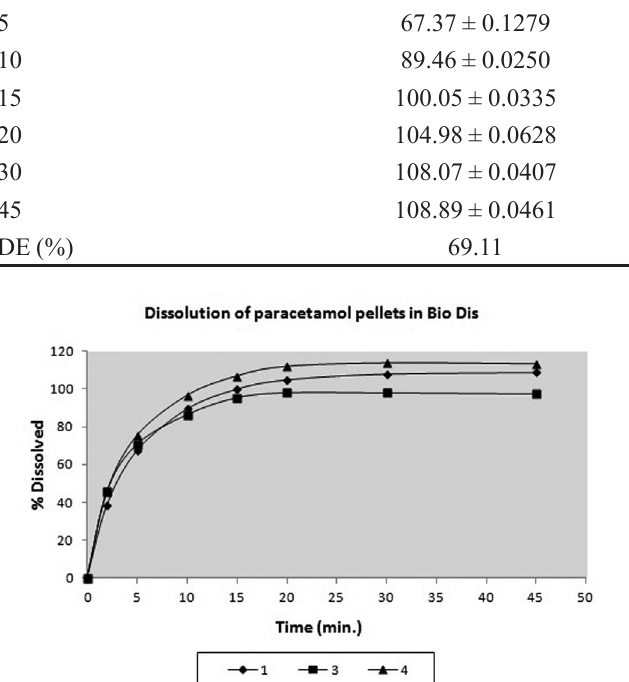
FIGURE 4 - Dissolution profiles obtained in Bio-Dis for formulations 1, 3 and 4. Media: up to 5 minutes - phosphate buffer pH 7.2 and HCl 0.1 N added to the dissolution vat after 5 minutes.